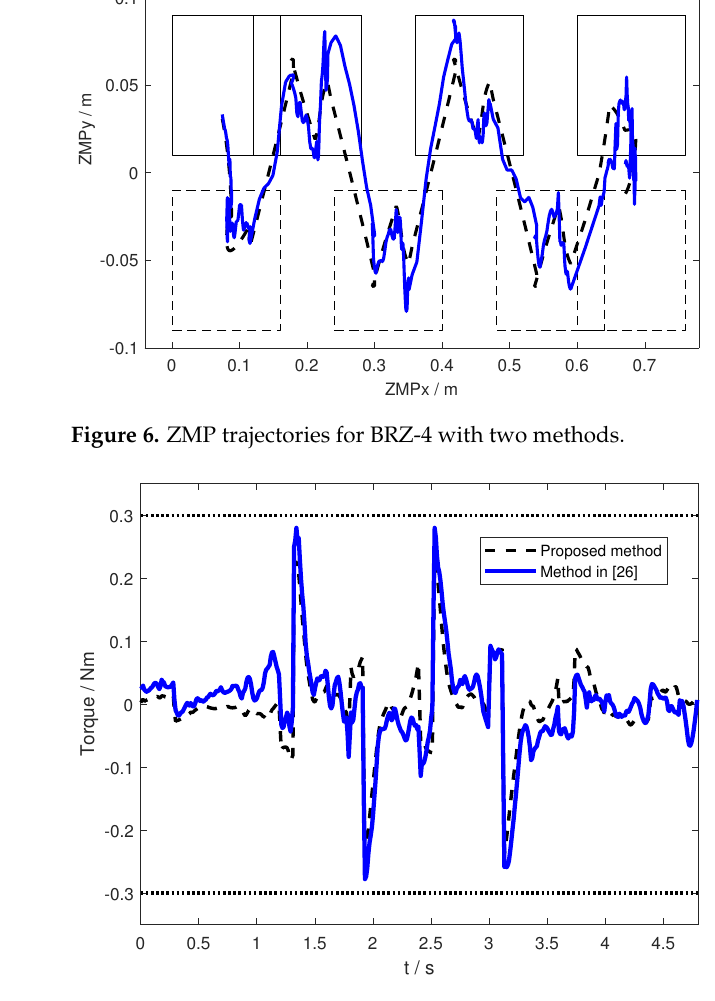
Figure 7. Yaw moment evolutions for BRZ-4 with two